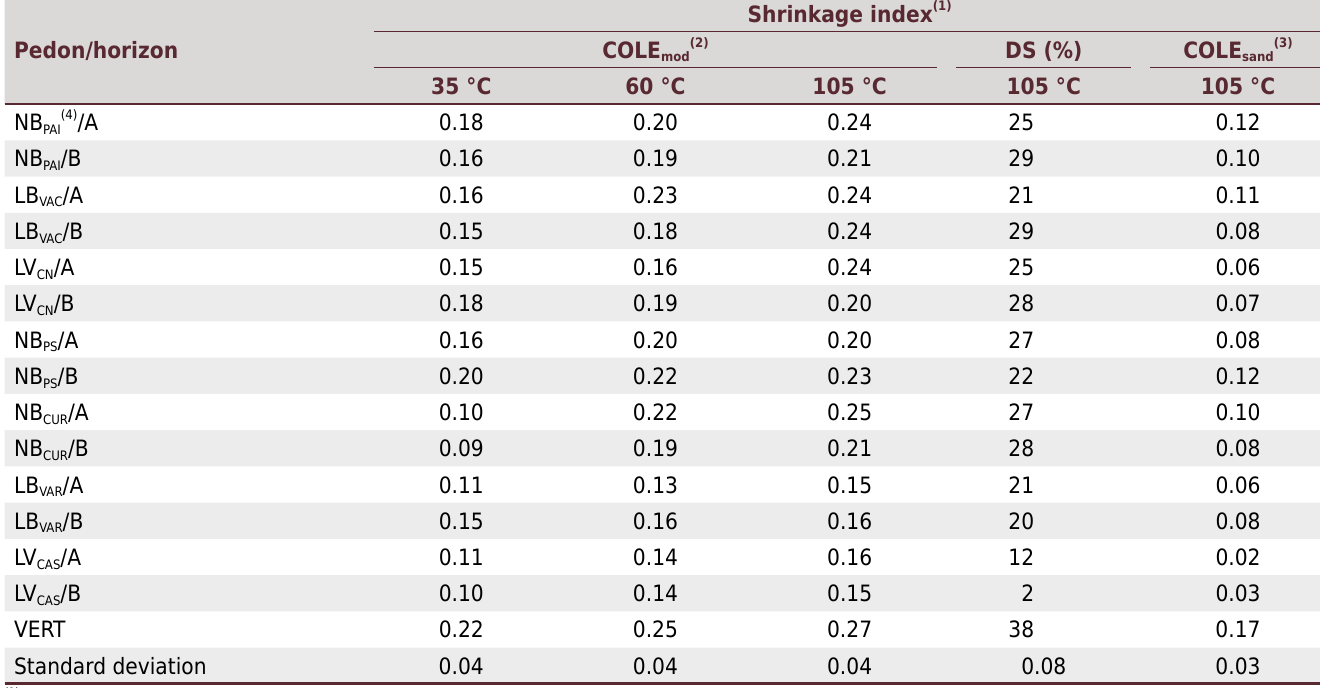
Table 2. Shrinkage of soils obtained by the Syringe Method - COLE mod (Schafer and Singer, 1976), Metallic Mercury Method - DS (Donagema et al., 2011), and Ring with Sand Method - COLE sand